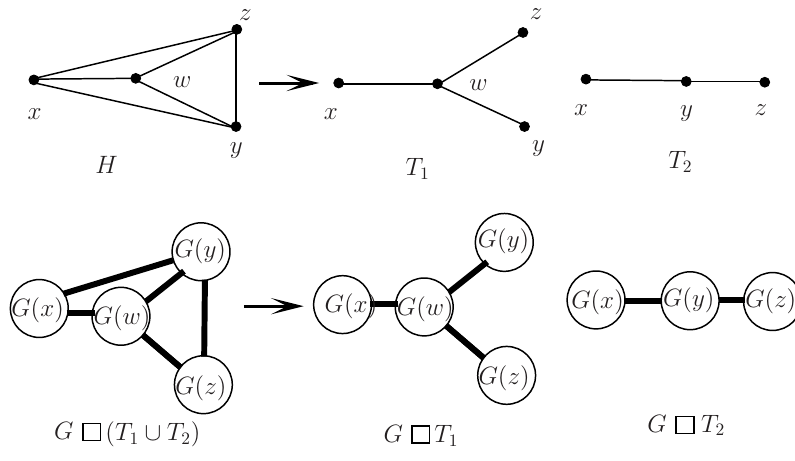
Fig. 5: The structure of G